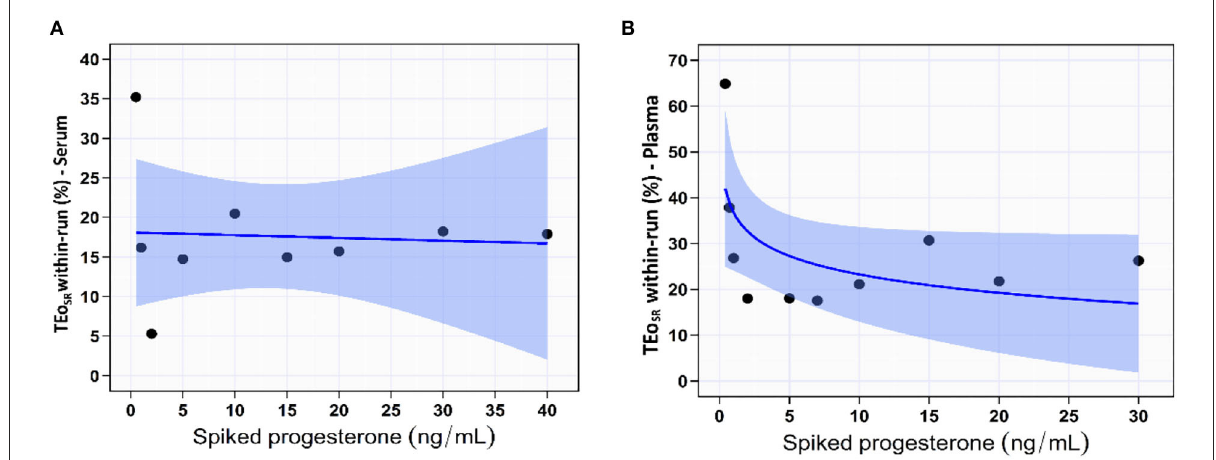
FIGURE6 Observed total error percentage (TEo) of IMMULITE ® 2000 XPi Progesterone immunoassay across the spiked serum (A) and plasma (B) progesterone concentrations. The solid blue lines are the best-fit regression lines. The light blue shaded areas indicate the 95% confidence bands for the regression